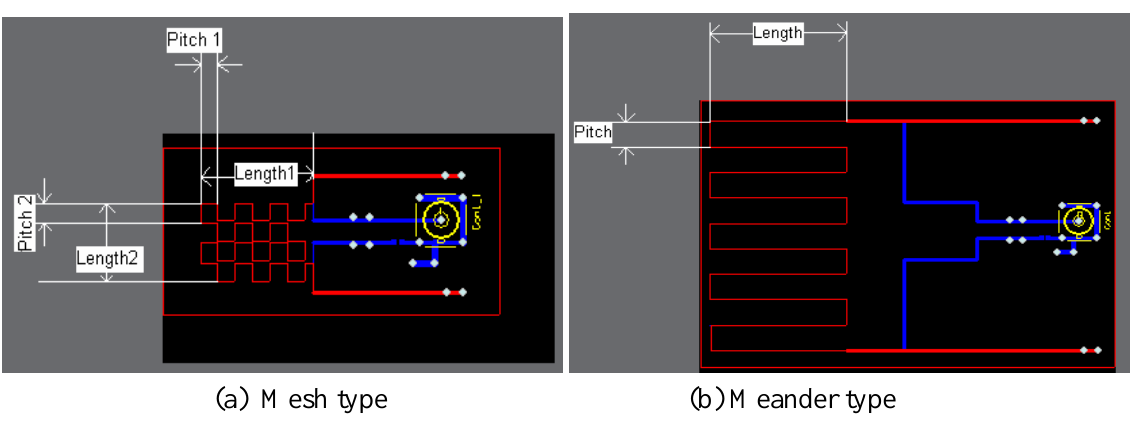
Figure 1. Configuration of planar electromagnetic sensors, mesh and meander type.